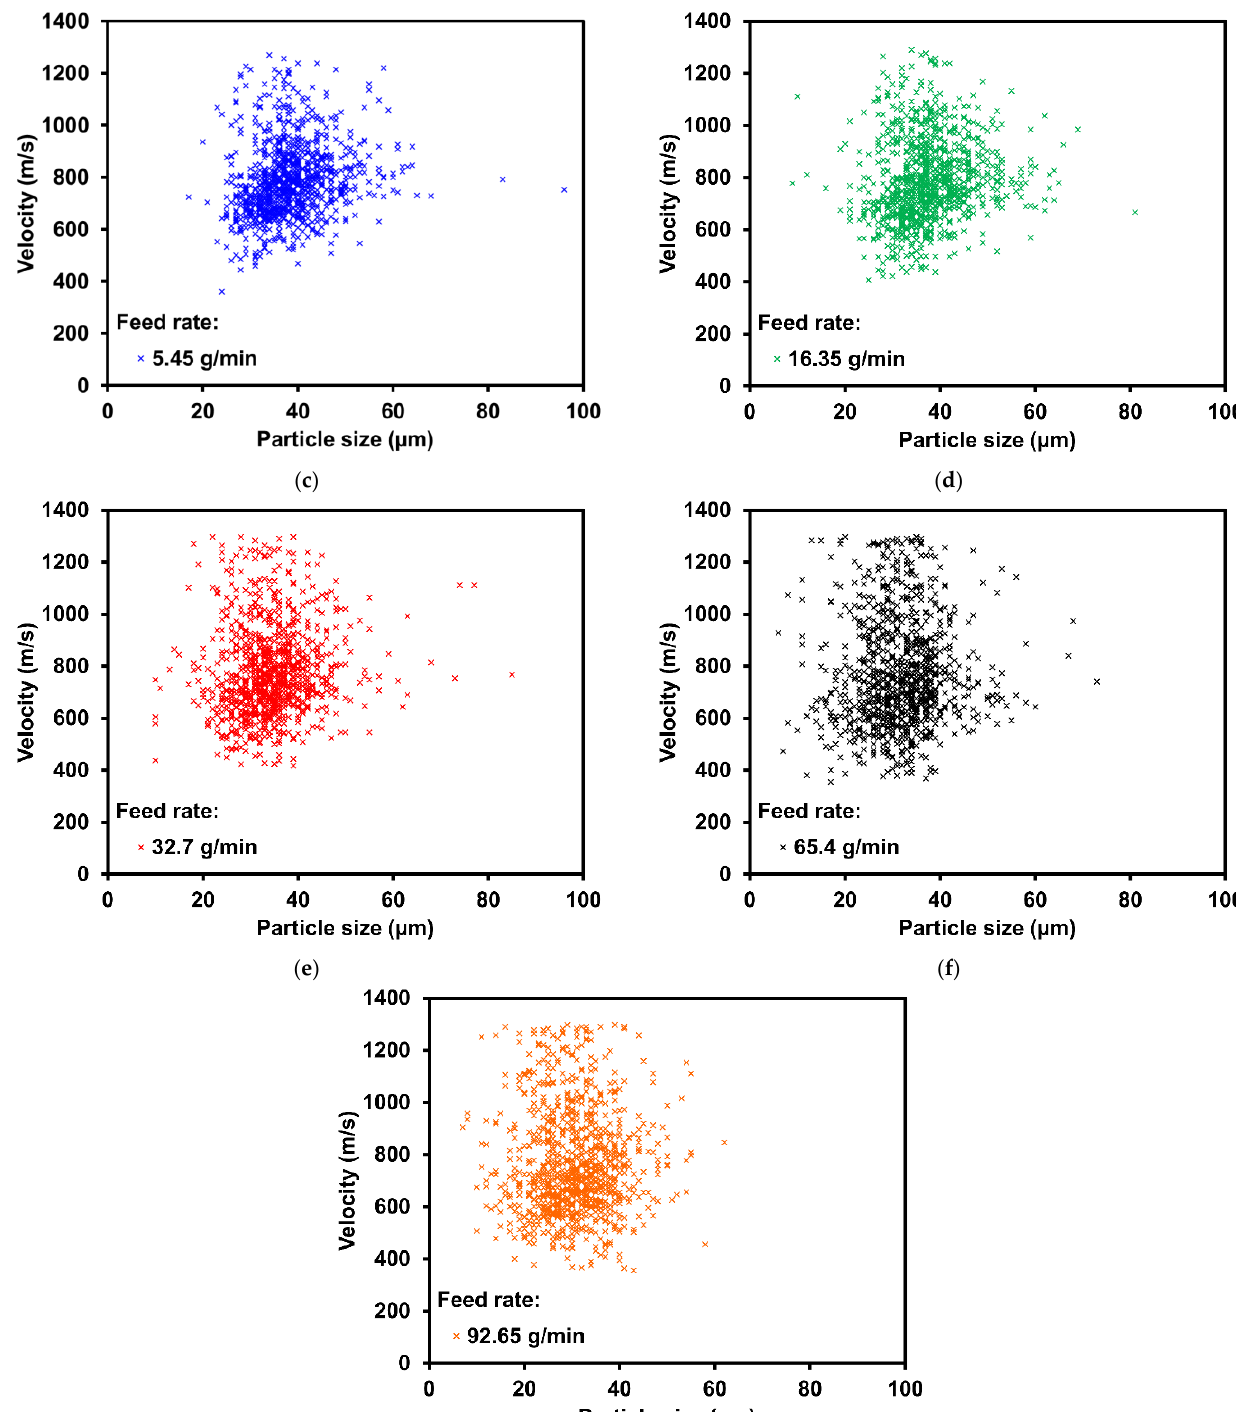
Figure 3. ( a ) Velocity measurement at different powder feed rates. The velocity change is not significant by changing the powder feed rate. Inset figure shows the magnified graph to clearly observe the trend. ( b ) Individual particle velocity measurement corresponding to the particle size and feed rate in 3D graphical format and in 2D graphical format for ( c ) 5.45 g/min, ( d ) 16.35 g/min, ( e ) 32.7 g/min, ( f ) 65.4 g/min, and ( g ) 92.65 g/min feed rates.